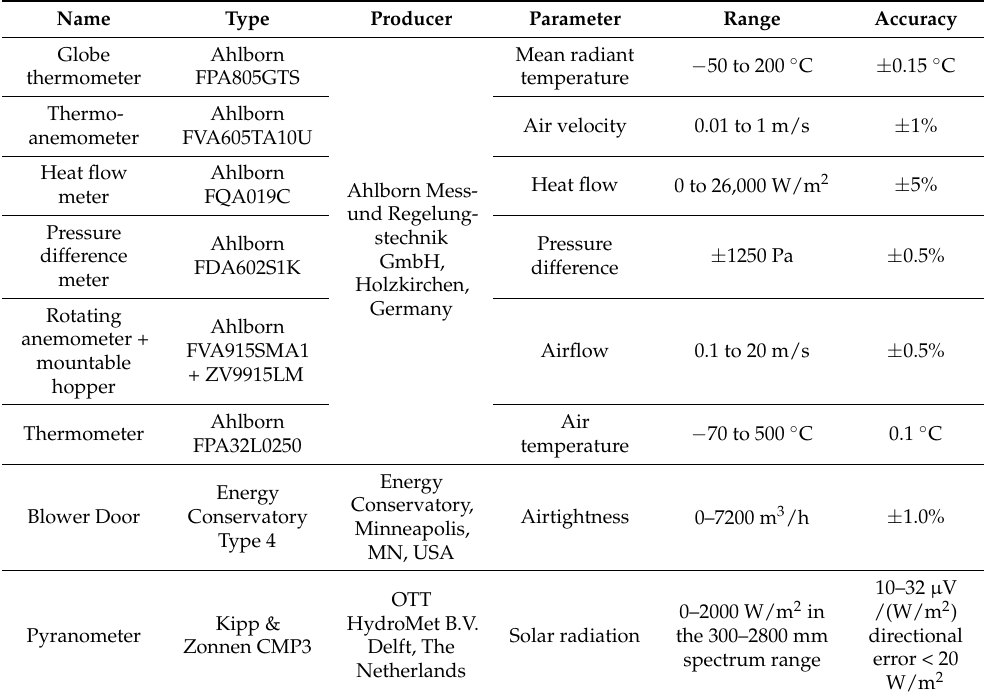
Table 1. Test instruments, producers, range, and